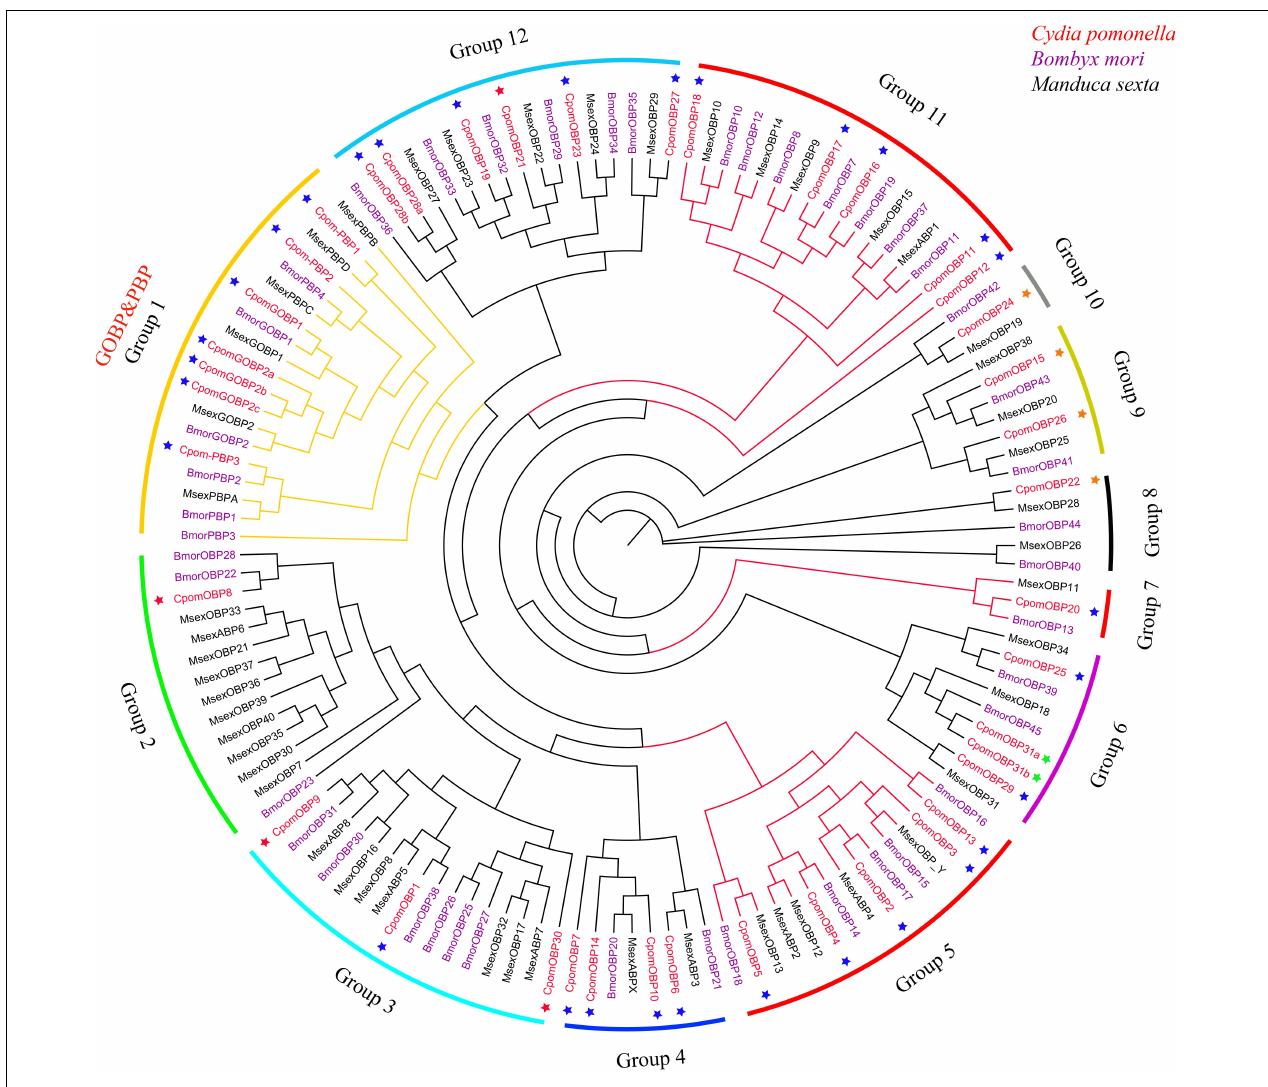
FIGURE 3 | The phylogenetic tree of the OBP gene family in lepidopteran insects. C. pomonella OBPs are classified as Classic, Minus-C, Plus-C, and Atypical, which are represented by blue, red, orange, and green stars, respectively. The GOBP/PBP genes are shown in